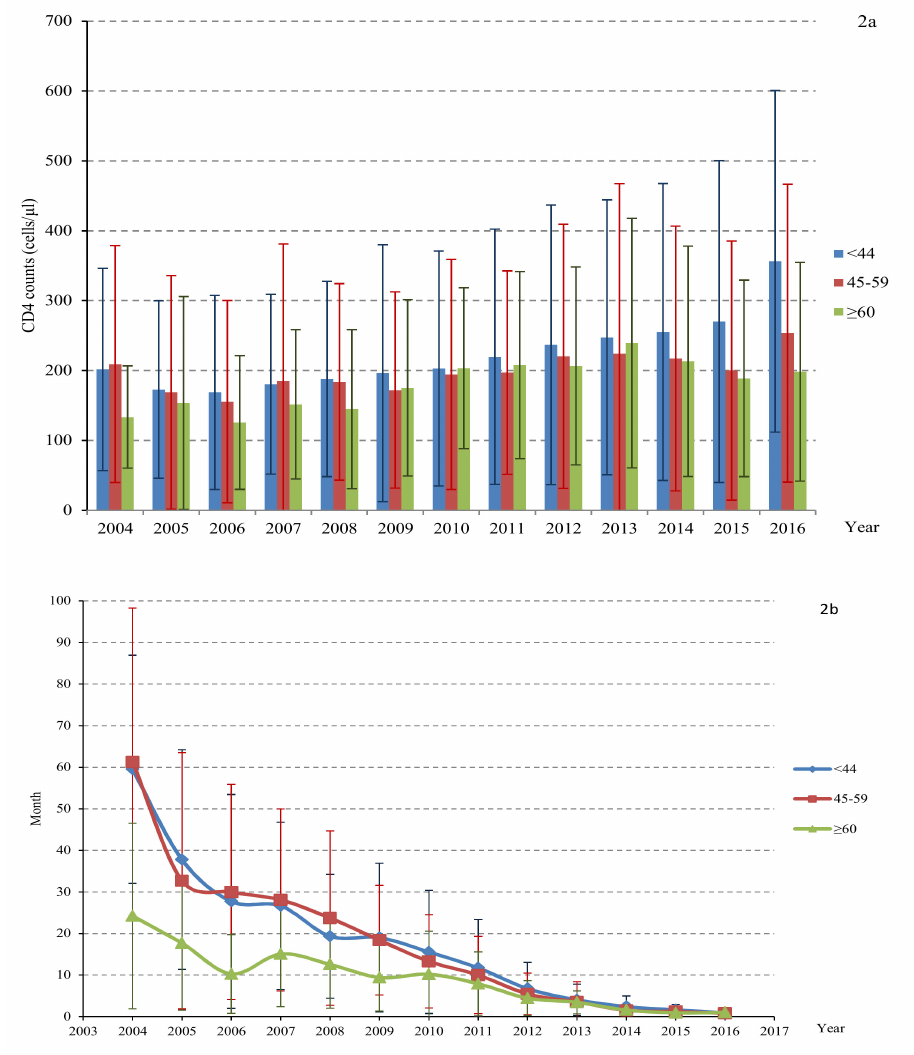
Figure 2. The CD4 counts at diagnosis ( a ) and lag time between HIV diagnosis and initial ART ( b ) by